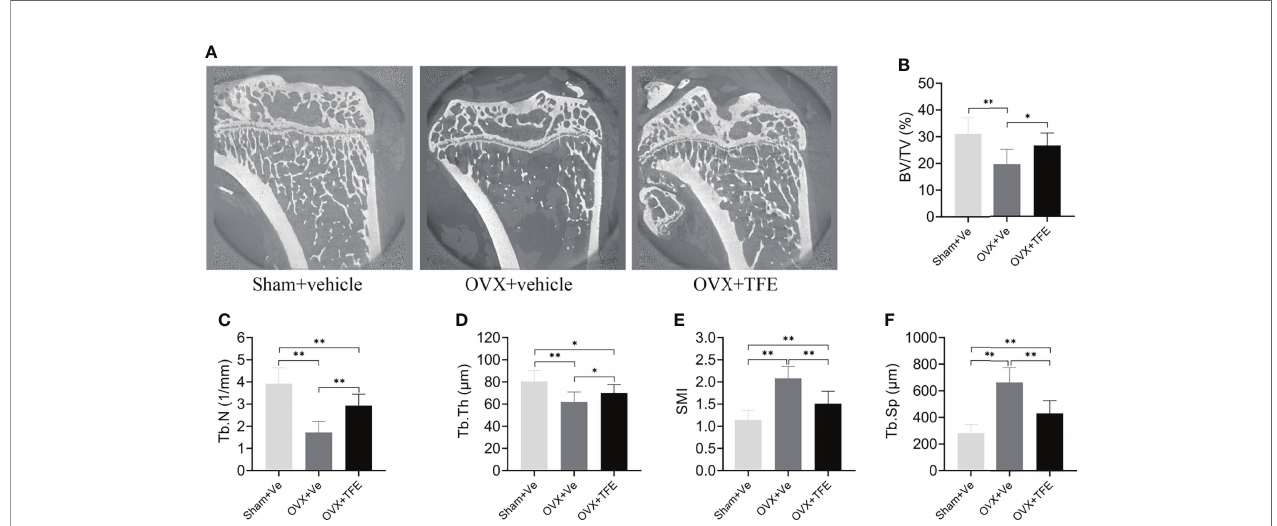
FIGURE 5 | Effects of TFE treatment on bone trabeculae microstructure in the tibia in OVX rats. Sagittal views of micro-CT images at the proximal tibia region (A) showed deterioration of trabecular microstructure in OVX rats, and TFE treatment improved bone trabeculae microstructure. TFE-treated rats showed responses to the OVX-induced losses of (B) BV/TV, (C) Tb.N, (D) Tb.Th, (E) SMI, and Tb.Sp (F) . BV/TV, bone volume fraction; Tb. Sp, trabecular separation; Tb.N, trabecular number; Tb.Th, trabecular thickness; SMI, structure model index; OVX, ovariectomy; Sham, sham-operation; TFE, total fl avonoids of Epimedium; Ve, vehicle. Data are shown as mean ± SD (Sham, n = 11; OVX, n = 10; TFE, n = 11). * P <0.05 and ** P <0.001 between groups analyzed by One-way ANOVA with